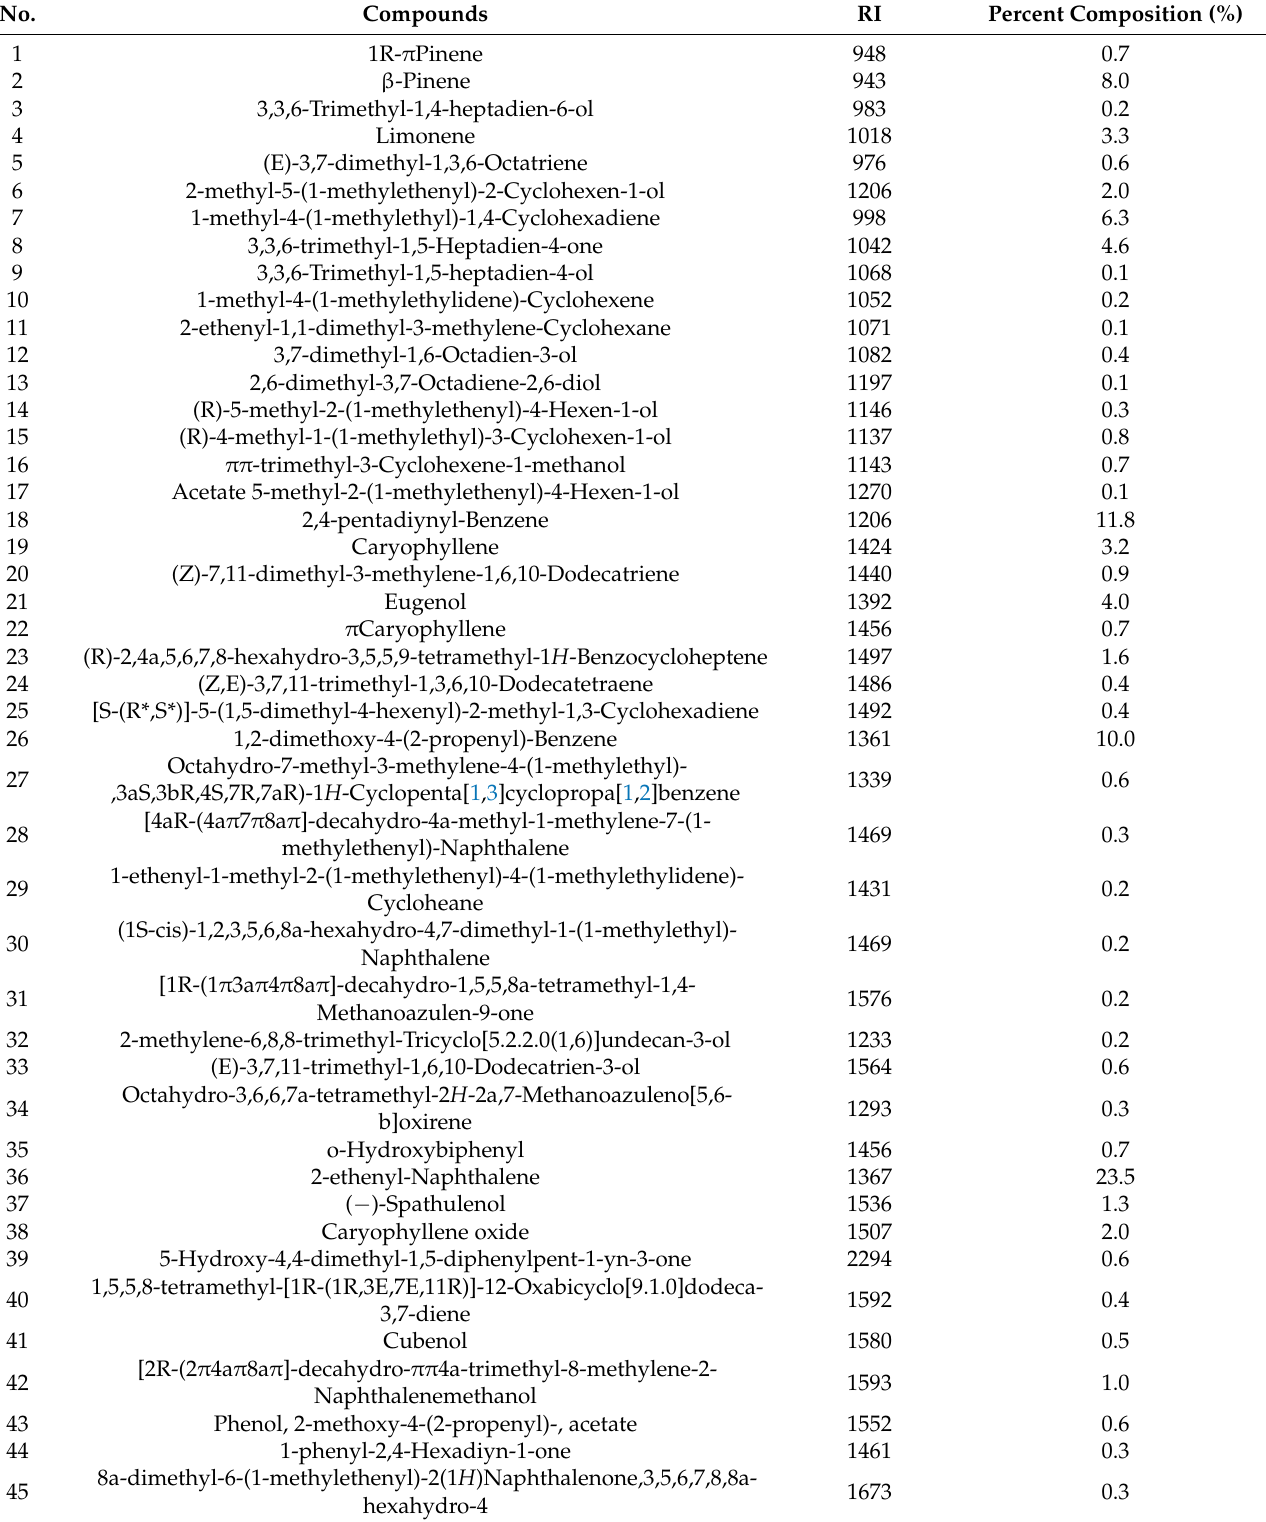
Table 5. Chemical composition of essential oil from A. scoparia